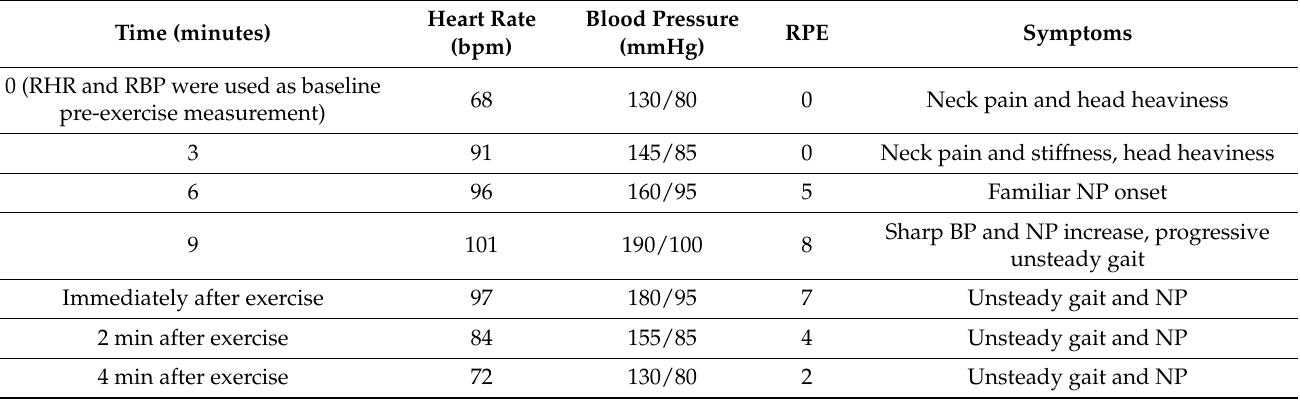
Table 1. Blood pressure measurement during